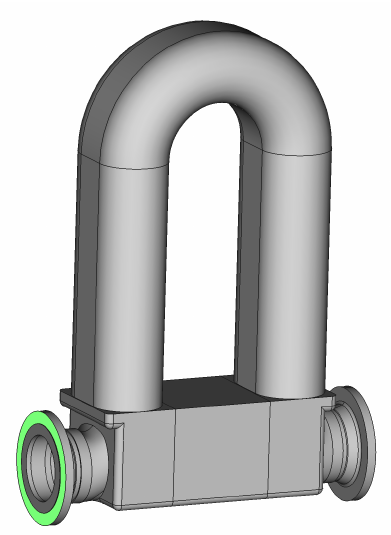
Figure 5. Boundary faces at the flanges